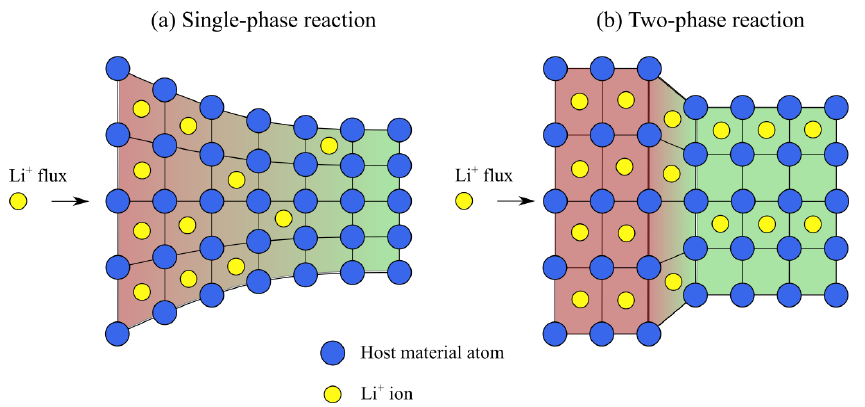
Figure 1. Mechanical stress resulting from inhomogeneous concentration due to ( a ) single phase- reaction and ( b ) phase